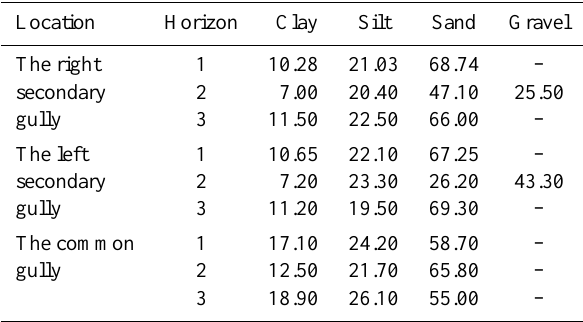
Table 2. The granulometric distribution in the alluvial horizons from the thalweg.